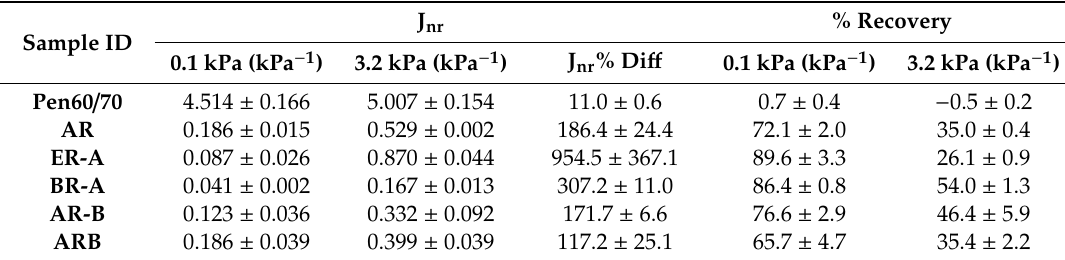
Table 2. MSCR test results.